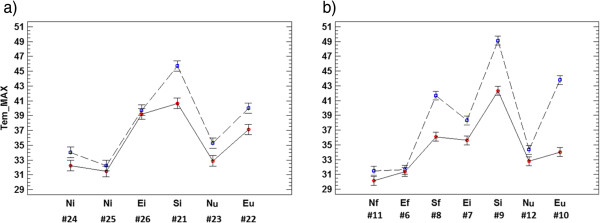
ANOVA results of Tmax in rooms 1 and 3: interaction plot. Plot (average and 95% LSD intervals) showing the effect of data-logger and year (2008: blue squares; 2010: red circles) on the daily maximum temperatures in room 1 (a) and room 3 (b) from August 14th to 31st. Codes as in Figure 
6.